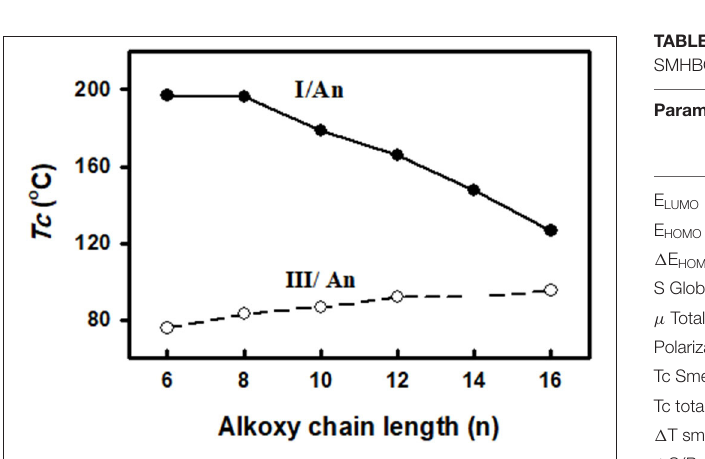
FIGURE 13 | Comparison of the mesophase stability between the present SMHBCs I/A n (•) and the previous system III/A n ( ◦ ).